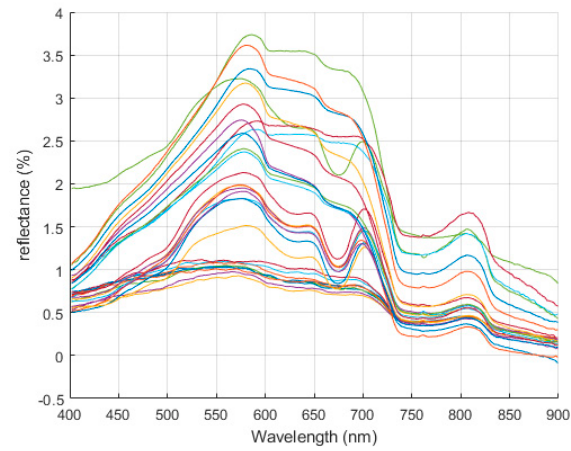
Figure 7. The 29 spectral curves extracted from the UAV-borne HRS images after the preprocessing.